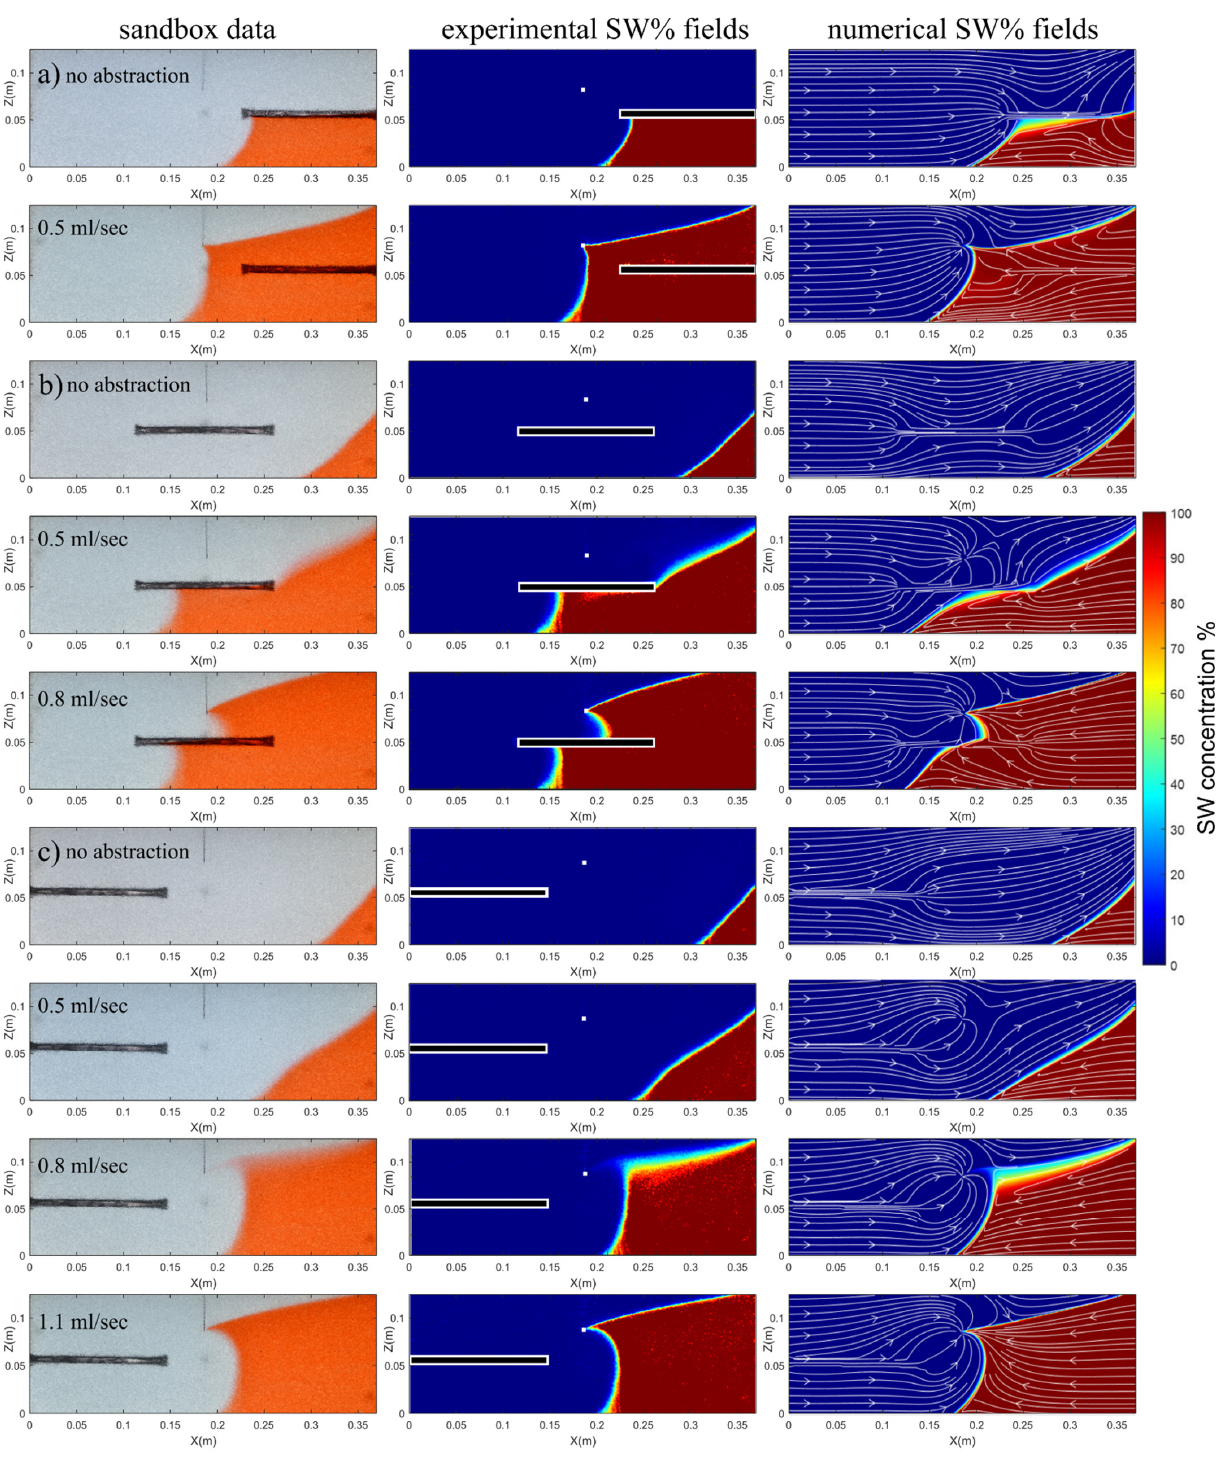
Figure 2. Photos of the pumping-induced laboratory saline intrusion ( left ) alongside experimental ( middle ) and numerical ( right ) saltwater concentration fields in the ( a ) fractured-right, ( b ) fractured-center and ( c ) fractured-left synthetic aquifers. The fracture’s position significantly affected the pre-pumping saltwater concentra- tion fields. The initial TL was the longest (16.1 cm) in the fractured-right aquifer, where